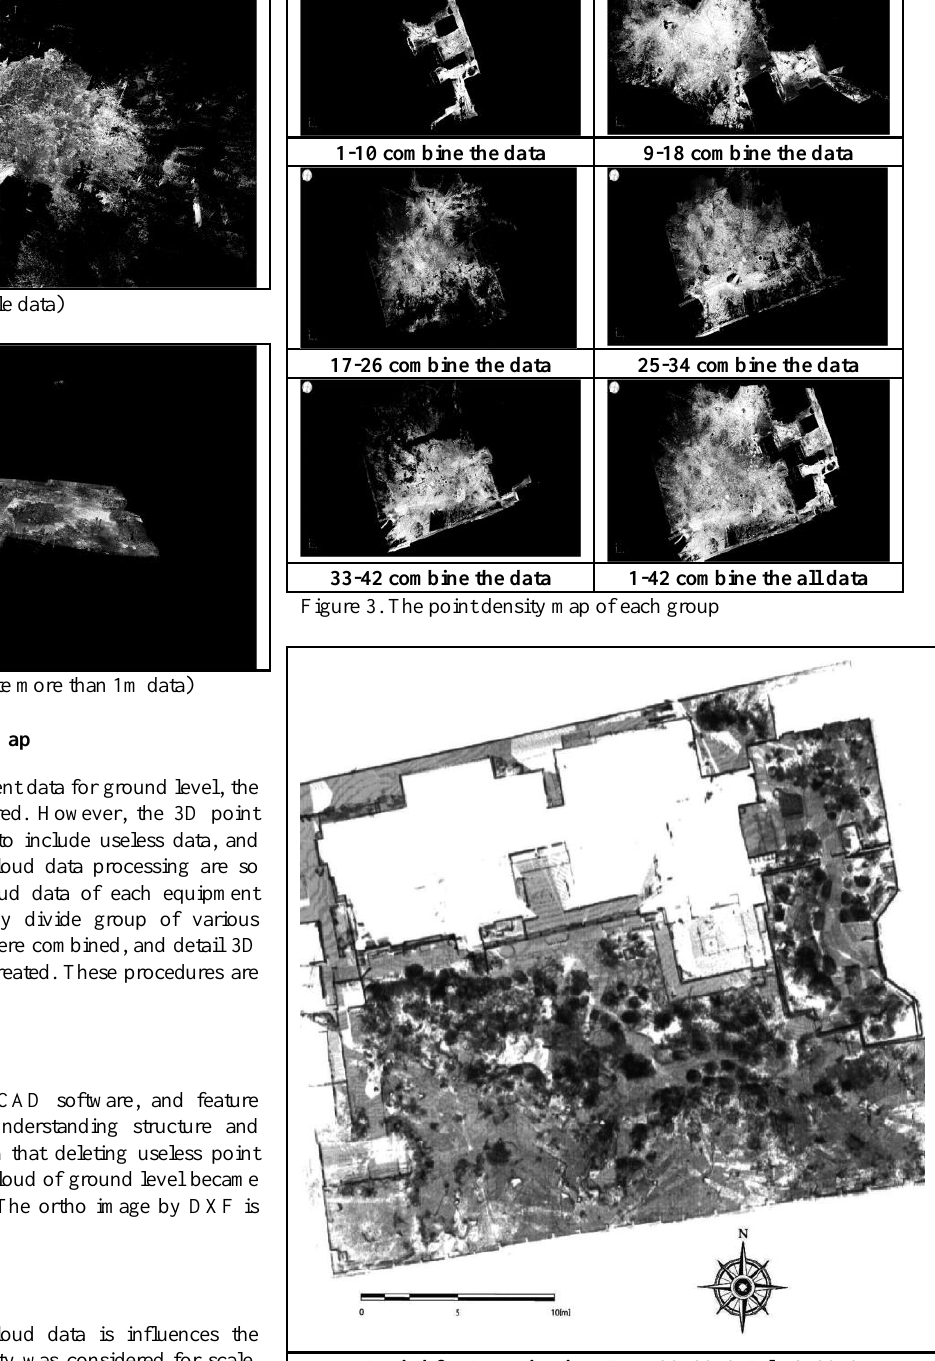
Period for Investigation: June 29, 2013-July 6,